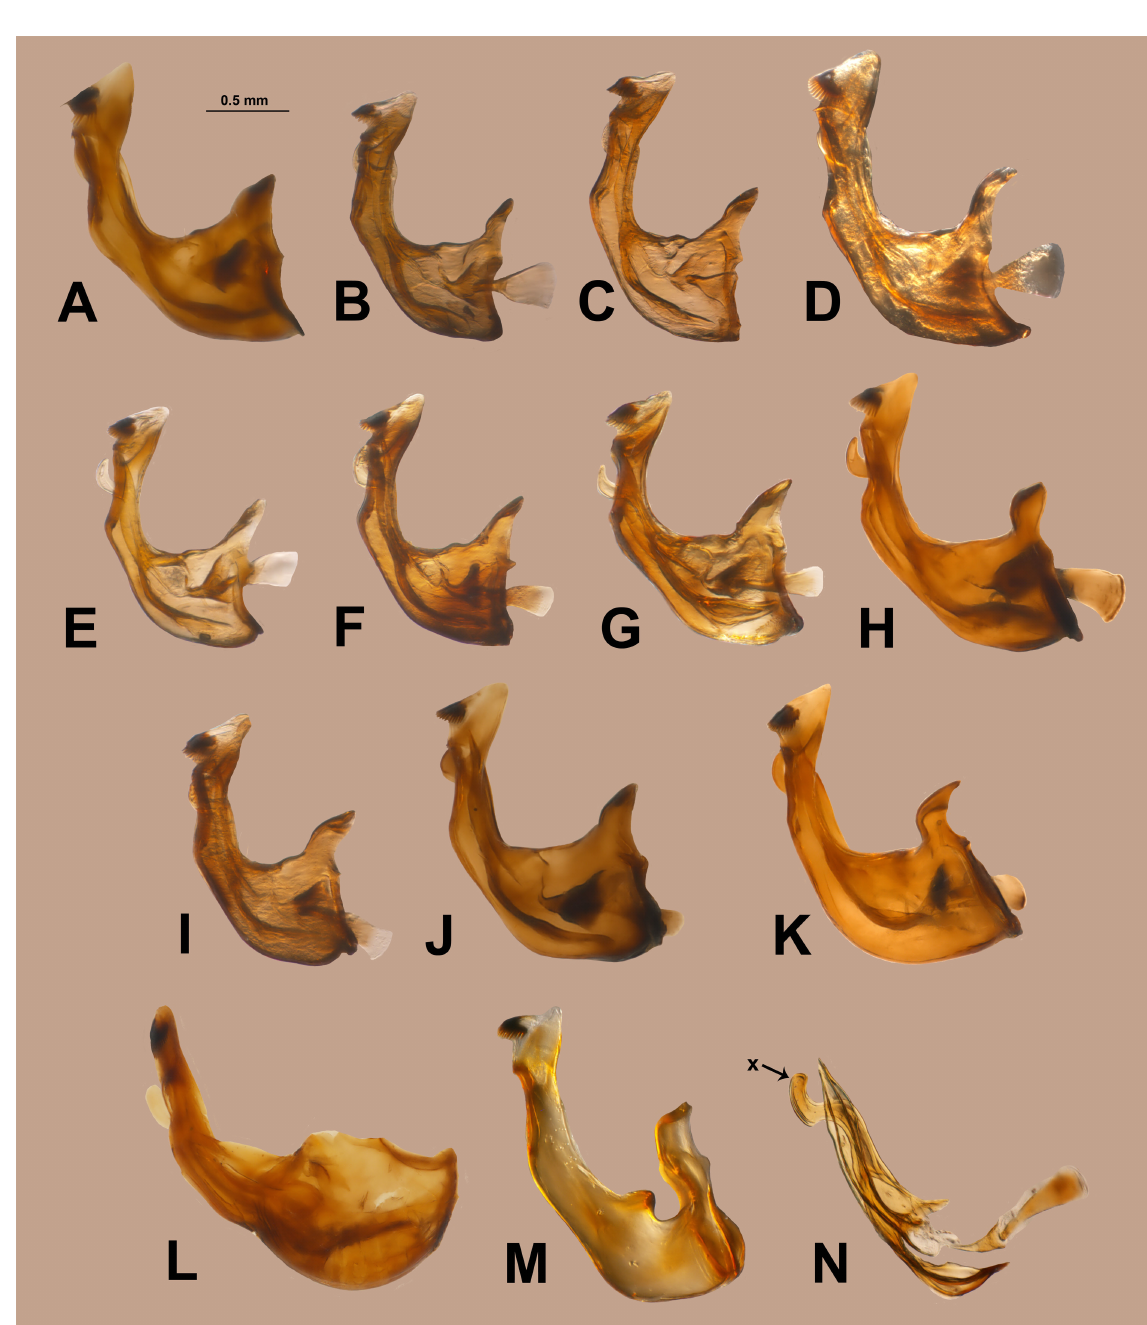
Fig. 11. Megatrigon spp., ♂ terminalia, hypandrium (a–M) and phallus (n), left lateral view. A . Megatrigon argenteus (Walker, 1852) comb. nov. B . M. argentifrons sp. nov. C . M. argentimaculatus sp. nov. D . M. magnicornis sp. nov. E . M. natalensis sp. nov. F . M. sexmaculatus sp. nov. G . M. apiformis sp. nov. H . M. cooksoni sp. nov. I . M. immaculatus sp. nov. J . M. ochreatus (Hull, 1964) comb. nov. K . M. tabanoides sp. nov. L . M. sp. from sexfasciatus group. M–N . M. nivalis (Hull, 1964) comb. nov. Symbol: x =